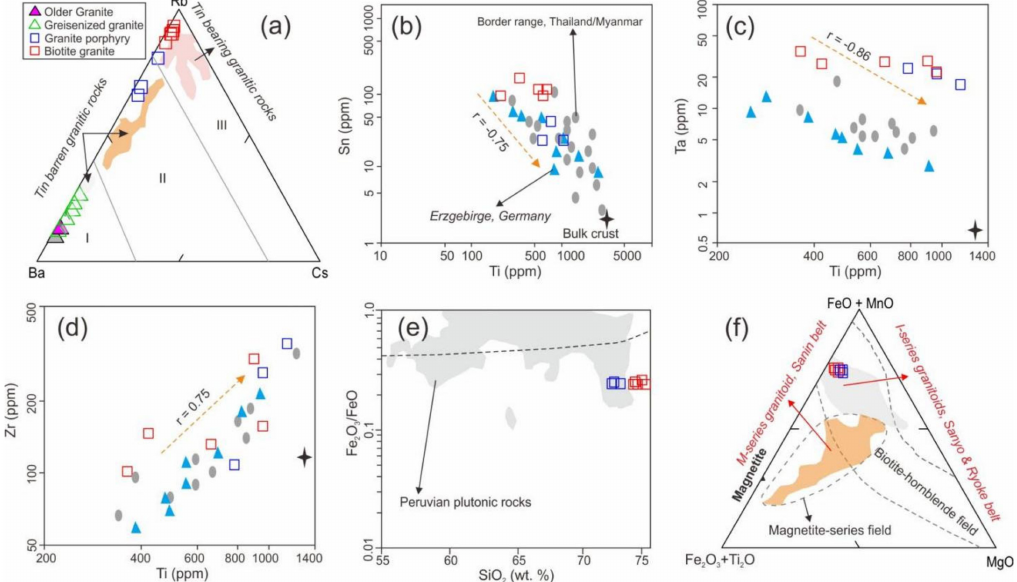
Figure 14. Magmatic discrimination plots of Older Granite, greisenized granite, and Younger Granite (including granite porphyry and biotite granite) from the Gindi Akwati deposit. ( a ) Rb-Ba-Cs diagram for granitic rocks, three areas distinguished: I = Sn ≤ 15 ppm, Rb/Ba < 0.48, Rb/Sr < 1.3; II = Sn > 15 ppm, 0.48 < Rb/Ba < 5, 1.3 < Rb/Sr < 15; III = Sn > 29 ppm, Rb/Ba > 5, Rb/Sr > 15 (after [61]); ( b – d ) Diagram of Sn vs. Ti, Ti vs. Ta and Ti vs. Zr for the Younger Granite in Gindi Akwati deposit and other granites related to tin mineralization from Thailand/Myanmar and Germany showing Sn sequestration into early crystallizing Ti-bearing phases (after [6,62]); ( e ) Diagram of Fe 2 O 3 /FeO vs. SiO 2 (wt. %) for the Younger Granites. The broken line is a separation line between magnetite-series and ilmenite-series (after [68]); ( f ) Diagram of Fe 2 O 3 + TiO 2 − MgO − FeO + MnO for the Younger Granite in Gindi Akwati deposit, showing that the samples lie in the ilmenite-series field (after [69]). For Figure 14e and f, the FeO and Fe 2 O 3 from total iron contents were calculated by using the excel spreadsheet in the article of Yang et al.